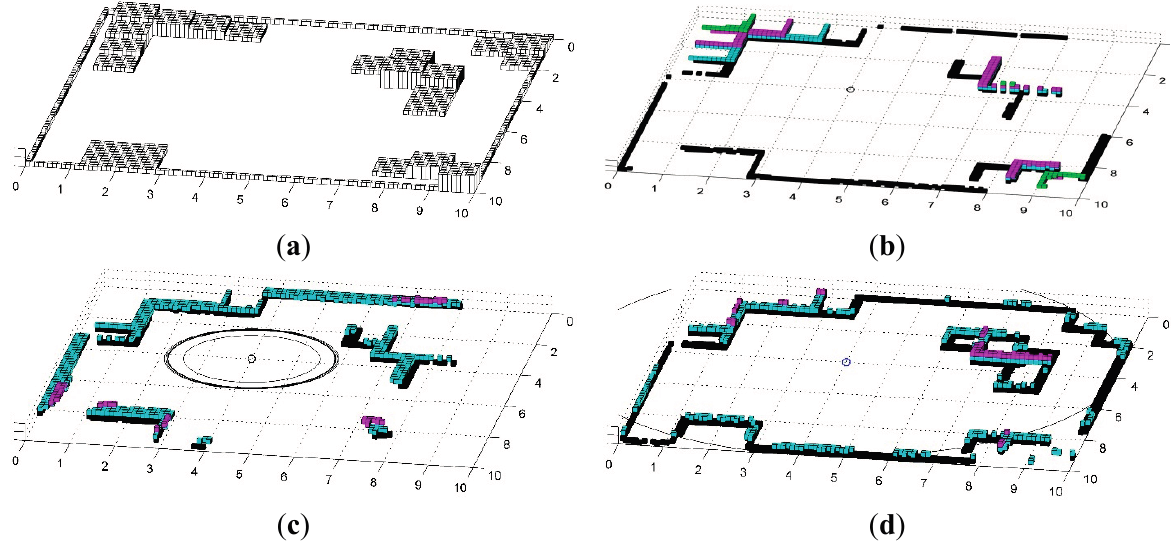
Figure 8. The performance of CESS in a 3D space. ( a ) The obstacle map; ( b ) The detected obstacles by LRF; ( c ) The detected obstacles by CESS, based on the vision-based positioning system; ( d ) The detected obstacles by CESS based on the UWB-based positioning